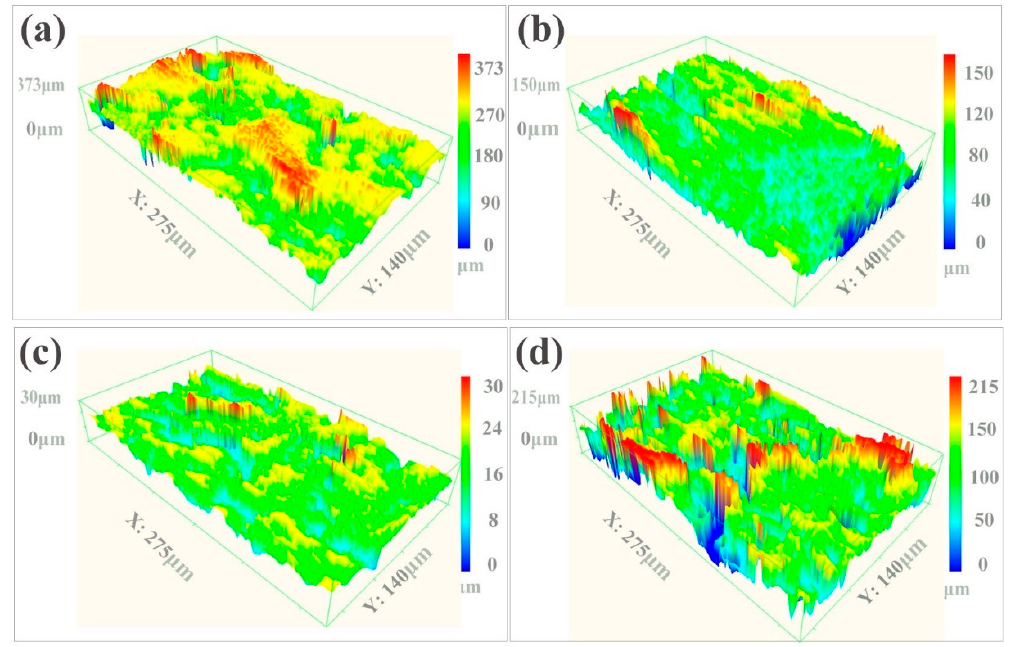
Figure 3. Laser scanning confocal microscope ( LSCM) images of the ( a ) as-received sample, the ( b ) LP-1 sample, the ( c ) LP-2 sample, and ( d ) the LP-3 sample.